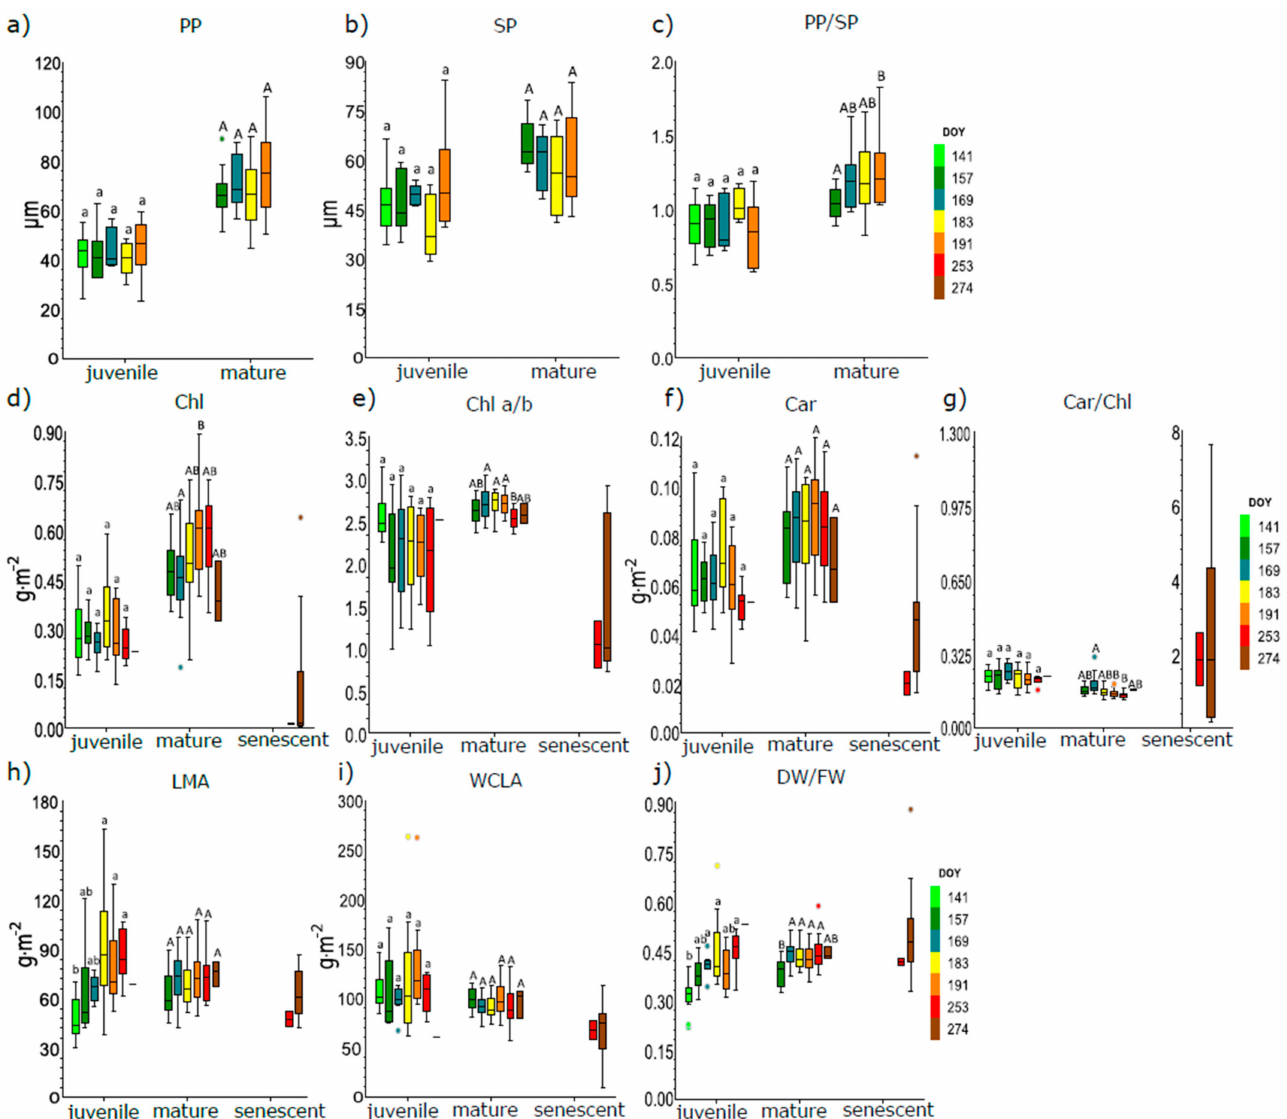
Figure 3. The mean values of anatomical and biophysical traits during the season (DOYs: 141, 157, 169, 183, 191, 253, and 274). Data were pooled according to the leaf developmental category (juvenile, mature, and senescent) ( a ) PP: palisade parenchyma thickness; ( b ) SP: spongy parenchyma thickness; ( c ) PP/SP: palisade/spongy parenchyma thickness ratio; (the analysis for DOYs 253, 274 were not performed for a–c); ( d ) Chl: chlorophyll a + b content; ( e ) Chl a/b: chlorophyll a/b ratio; ( f ) Car: carotenoids content; ( g ) Car/Chl: carotenoids/chlorophyll ratio; ( h ) LMA: leaf mass per area; ( i ) WCLA: water content per leaf area; ( j ) DW/FW: dry/fresh weight ratio. The difference among the DOYs in one group tested by analysis of variance, α = 0.05. Different colors correspond to individual DOYs during the season; line in boxes show median, bars in boxes show inter-quartile range (IQR); dots correspond to outliers defined as three times IQR; same letters show no significance, different letter show significant difference among DOYs within one graph at α =